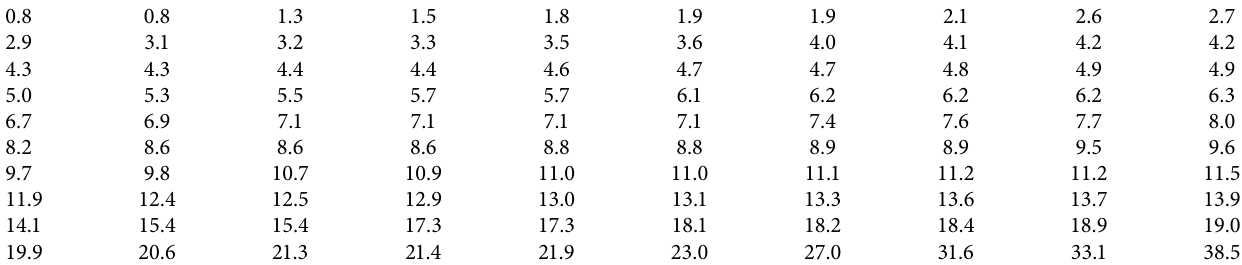
Table 3: Waiting times (in minutes) of customers to receive service in a bank.